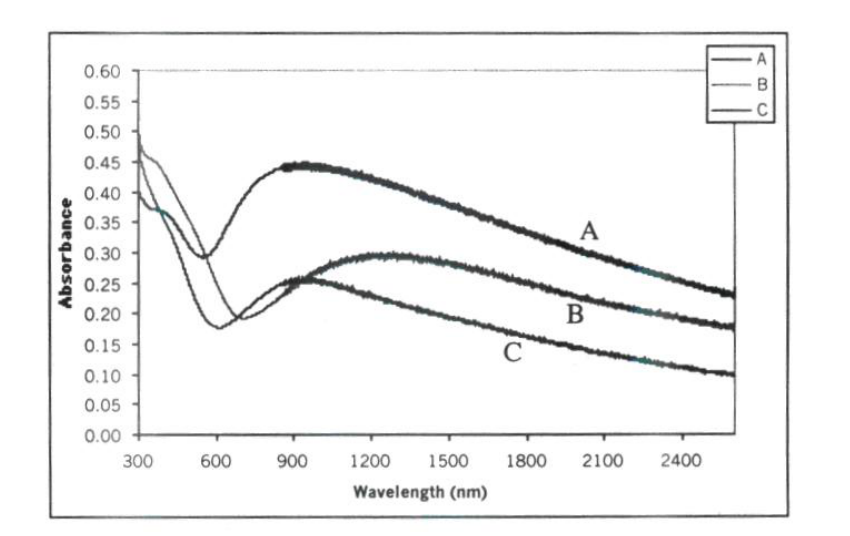
Figure 4. Polypyrrole response to A-as deposited, B- after exposure to hydrazine, C- after exposure to